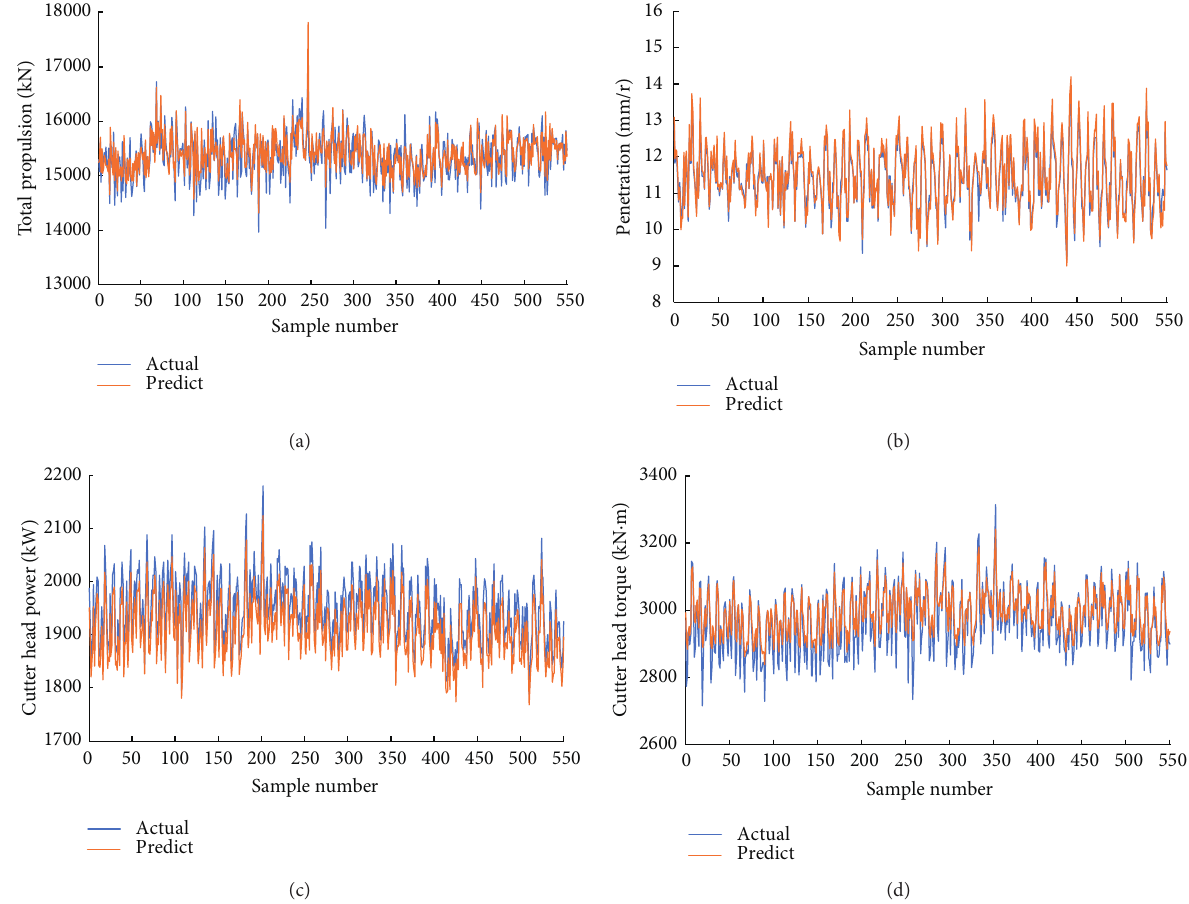
Figure 10: Prediction results of Bi-GRU-ATT model. (a) Prediction results of total thrust F . (b) Prediction results of penetration e . (c) Prediction results of cutterhead power P . (d) Prediction results of cutterhead torque T . Table 1: Evaluation indexes of prediction results of Bi-GRU-ATT model.